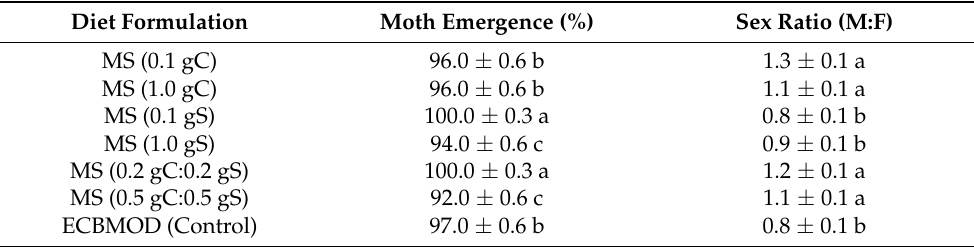
Table 6. Mean ( ± SE) emergence and sex ratio (Male: Female) of Eldana saccharina moths [ n = 130] from pupae harvested from the MS (0.1 gC), MS (1.0 gC), MS (0.1 gS), MS (1.0 gS), MS (0.2 gC:0.2 gS), MS (0.5 gC:0.5 gS) and ECBMOD control diets. Means within columns with different lower-case letters indicate significant differences ( p < 0.05).